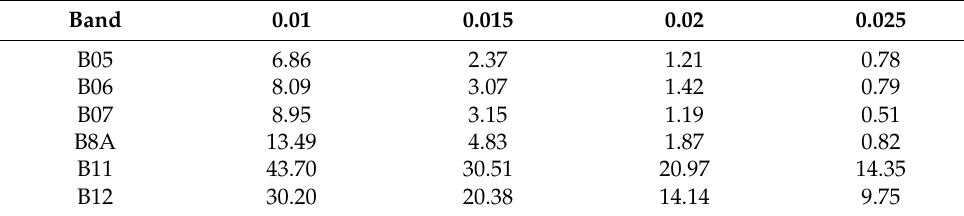
Table 6. Percentage of pixels beyond a given absolute error threshold (L1C).